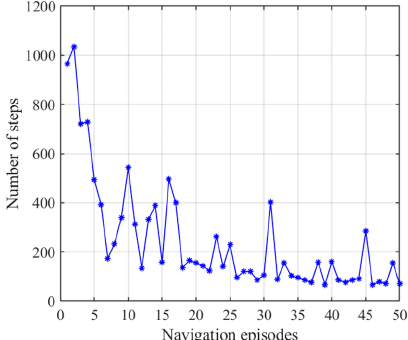
Figure 19. Number of steps with the striatal model alone when door B is closed. Blue asterisks indicate the navigation steps for each navigation episode.